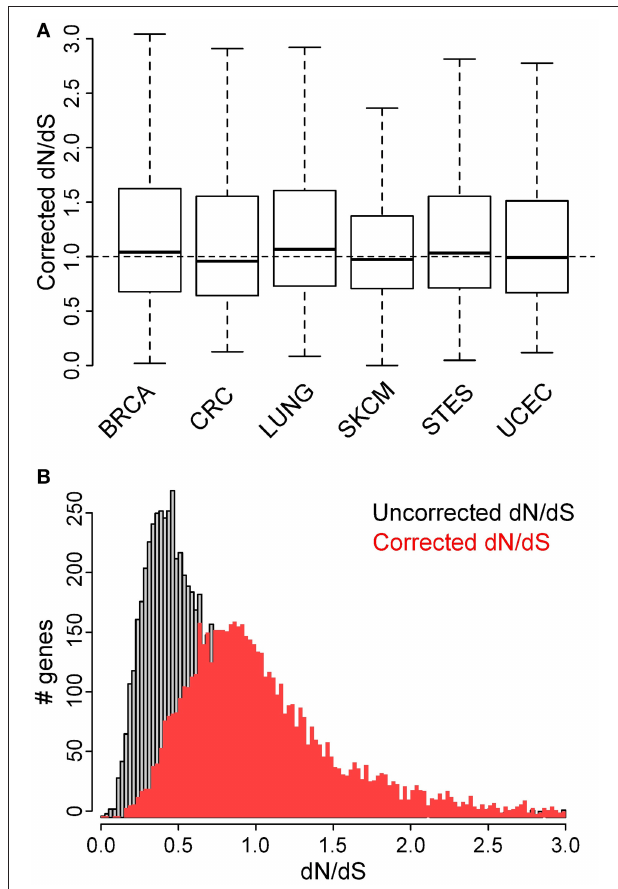
FIGURE 4 | Corrected dN/dS ratios, calculated using the 96-class mutation probabilities, do not indicate major differences between cancer types. (A) Comparison of dN/dS values between the 6 cancer types under analysis. (B) Comparison of histograms for uncorrected (gray) and corrected (red) dN/dS values for all genes that contain at least 10 point mutations in malignant